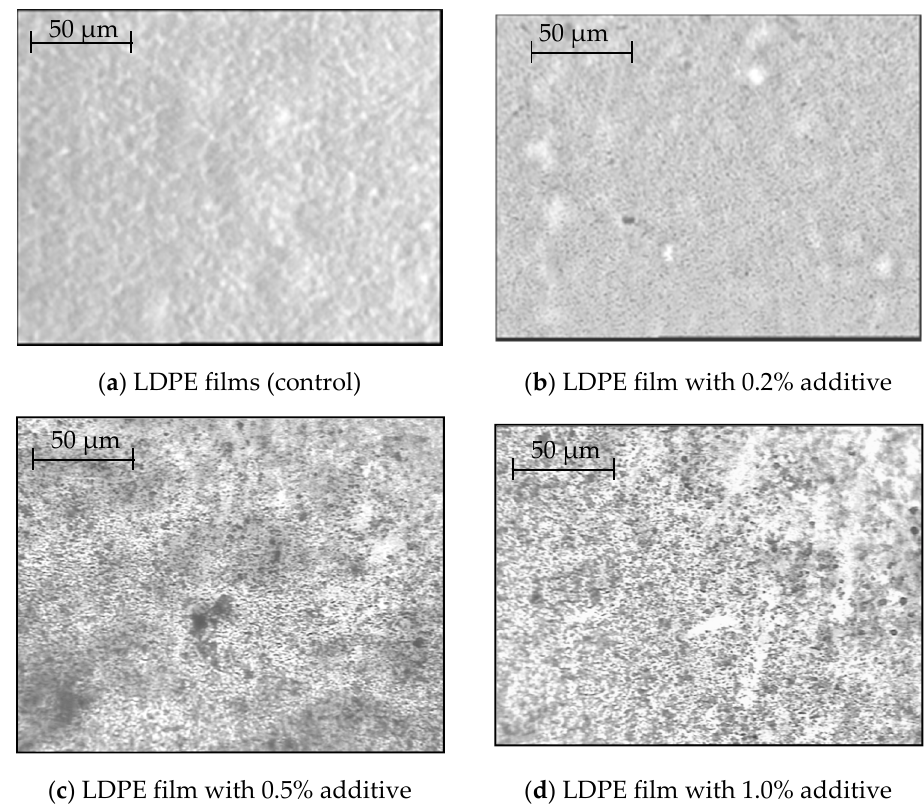
Figure 5. Photomicrographs of the surface of a betulin-modified LDPE film.